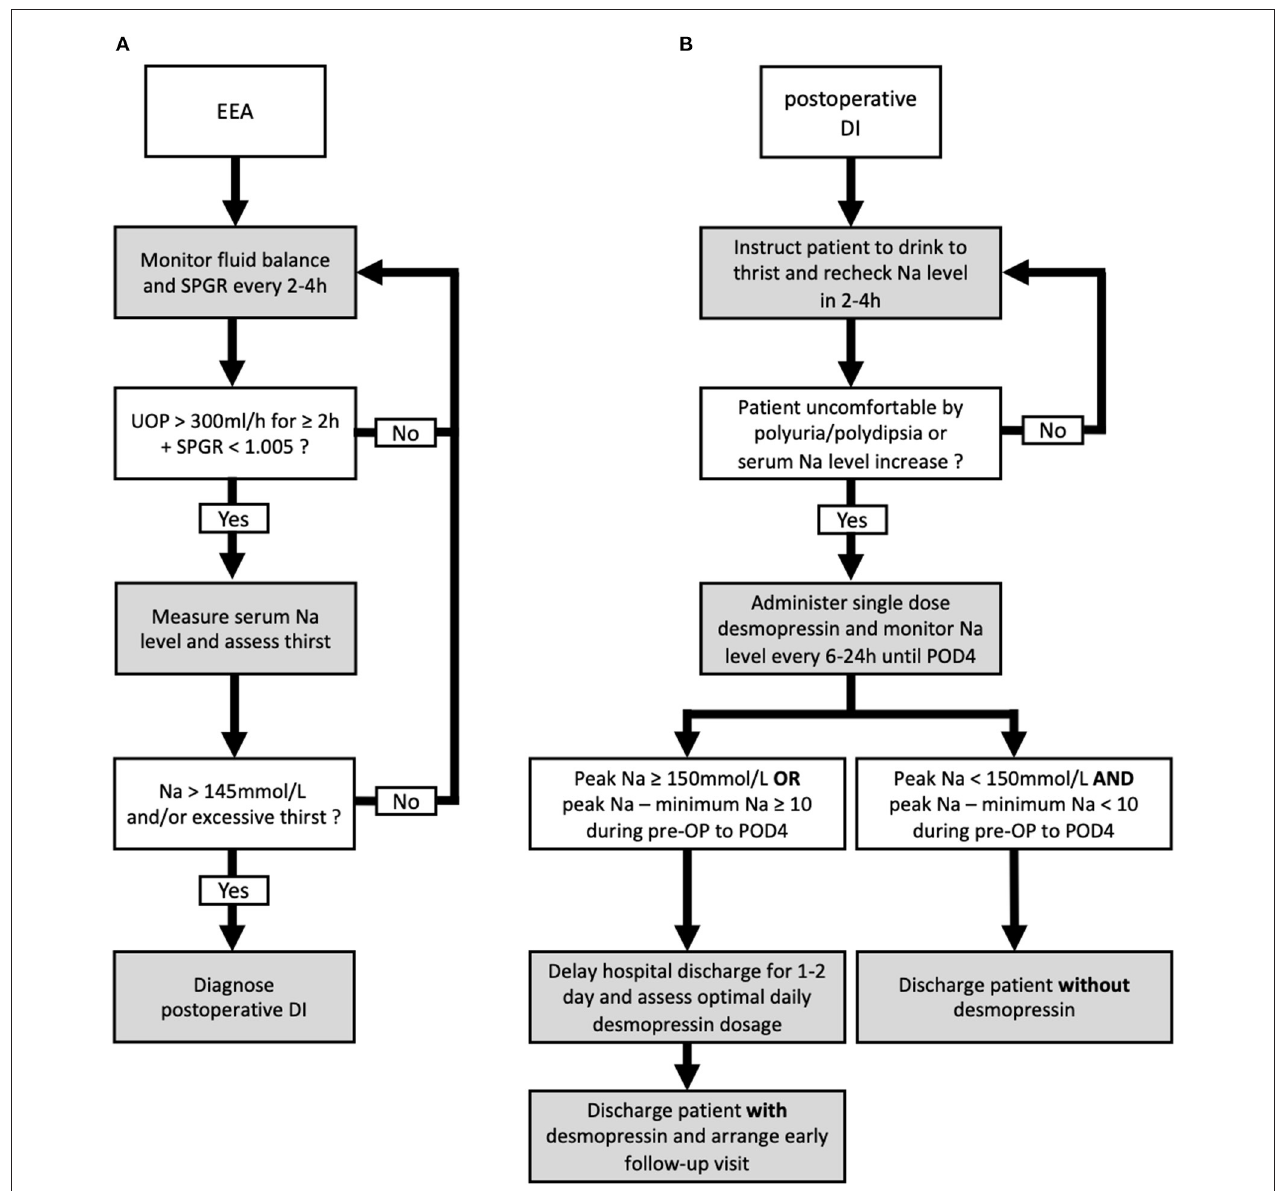
FIGURE 3 | Proposed algorithm for the diagnosis and management of postoperative diabetes insipidus (DI) following endonasal endoscopic approach (EEA). The proposed diagnostic (A) and management (B) algorithms including the discharge plan for postoperative DI following EEA.